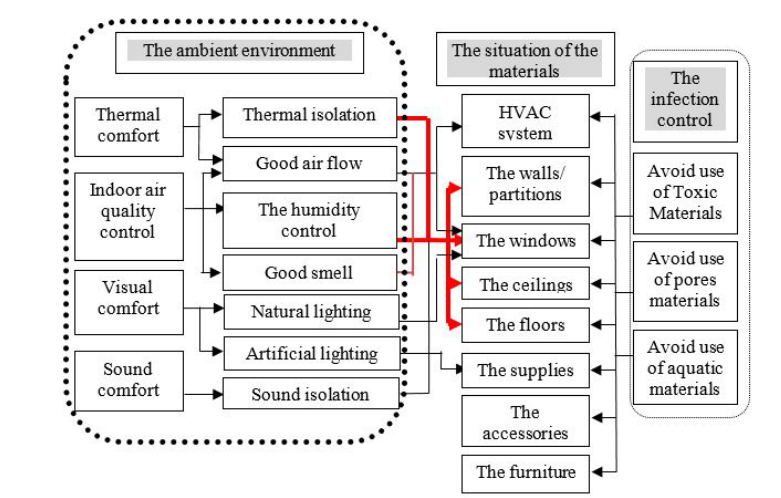
Figure 4. the relation between the materials and theambient environment and the infection control. (Cullinan,2010) (edit by theauthors).